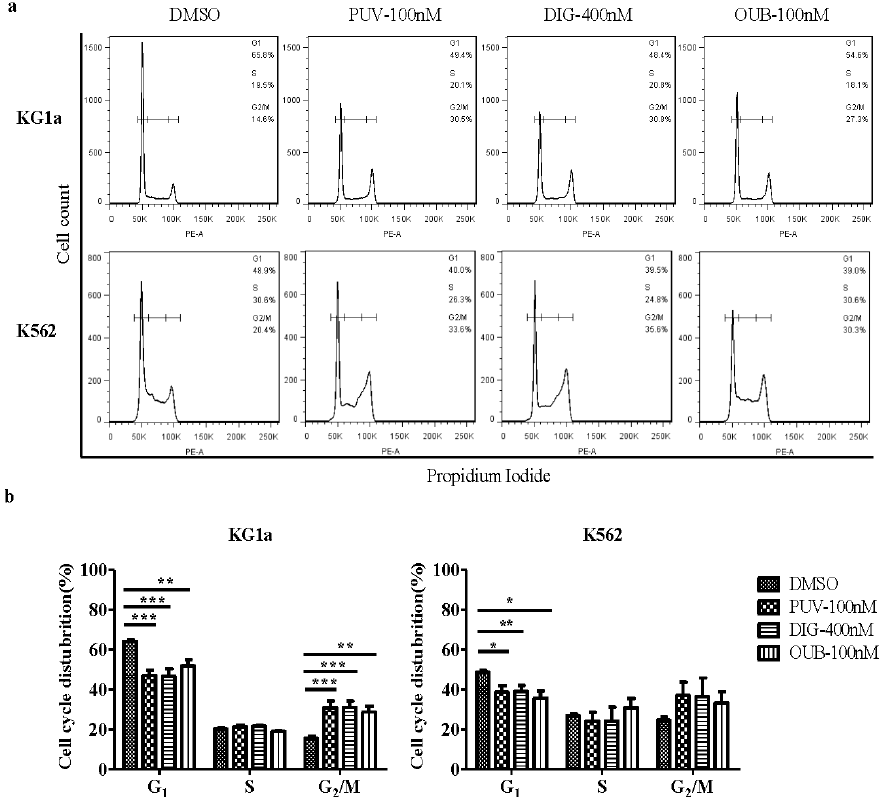
Figure 4. Peruvoside induces cell cycle arrest at G 2 /M, at a level similar to Digitoxin and Ouabain. ( a ) Cells treated with Peruvoside (100 nM), Digitoxin (400 nM) and Ouabain (100 nM) were stained with PI. Changes in cell cycle distribution of treated cells were analyzed by flow cytometry; ( b ) Graphs show cell cycle distributions of cells treated with different CGs shown in ( a ); PUV, Peruvoside; DIG, Digitoxin; OUB, Ouabain. n = 3, *, p < 0.05; **, p < 0.01, ***, p < 0.0001.